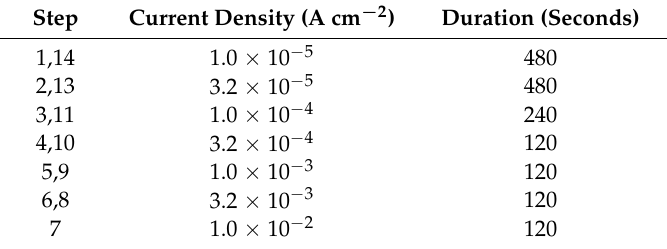
Table 2. Current densities and durations for Tafel analysis.